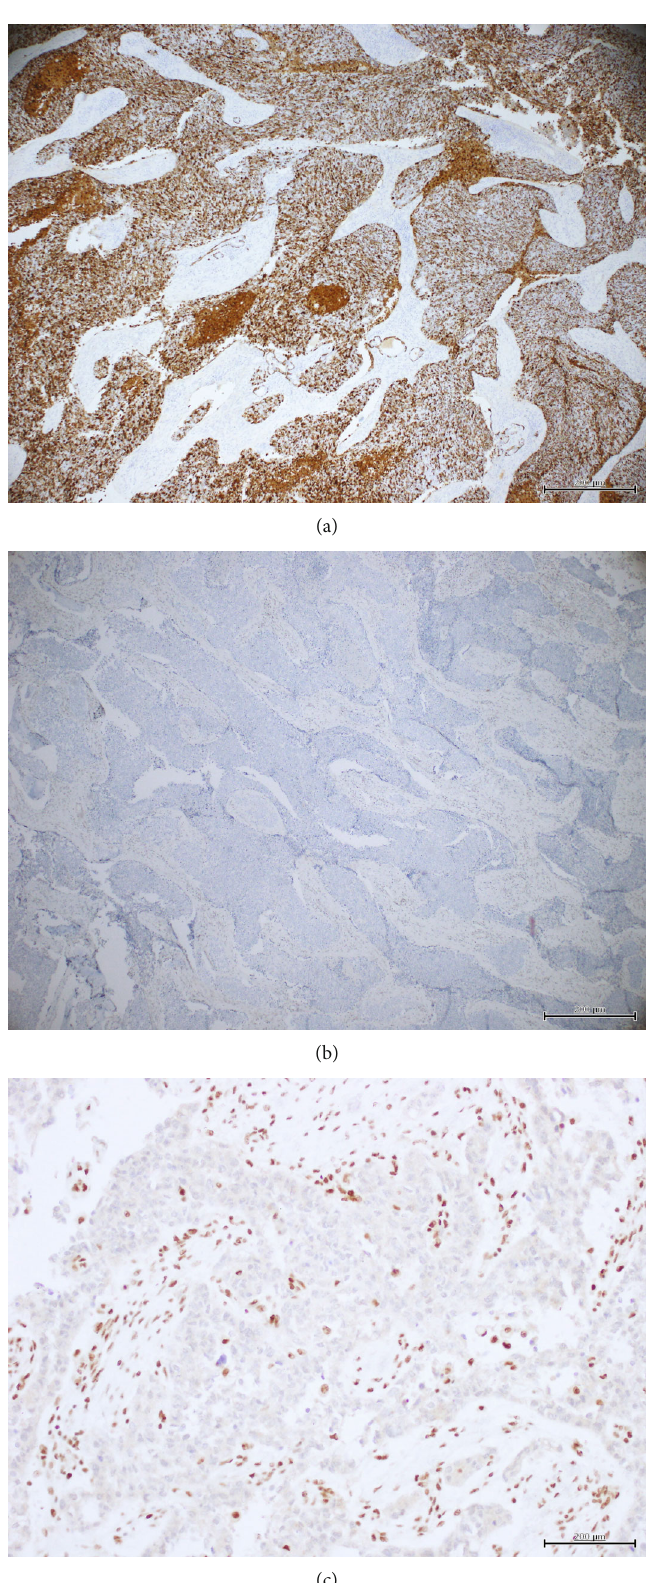
Figure 3: (a) The neoplastic cells show di ff use immunoreactivity for CK AE1/AE2 (original magni fi cation ( × 40)). (b) The tumor exhibits complete loss of INI-1 immunostaining ( × 40). (c) The tumor exhibits complete loss of INI-1 immunostaining with positive control ( ×